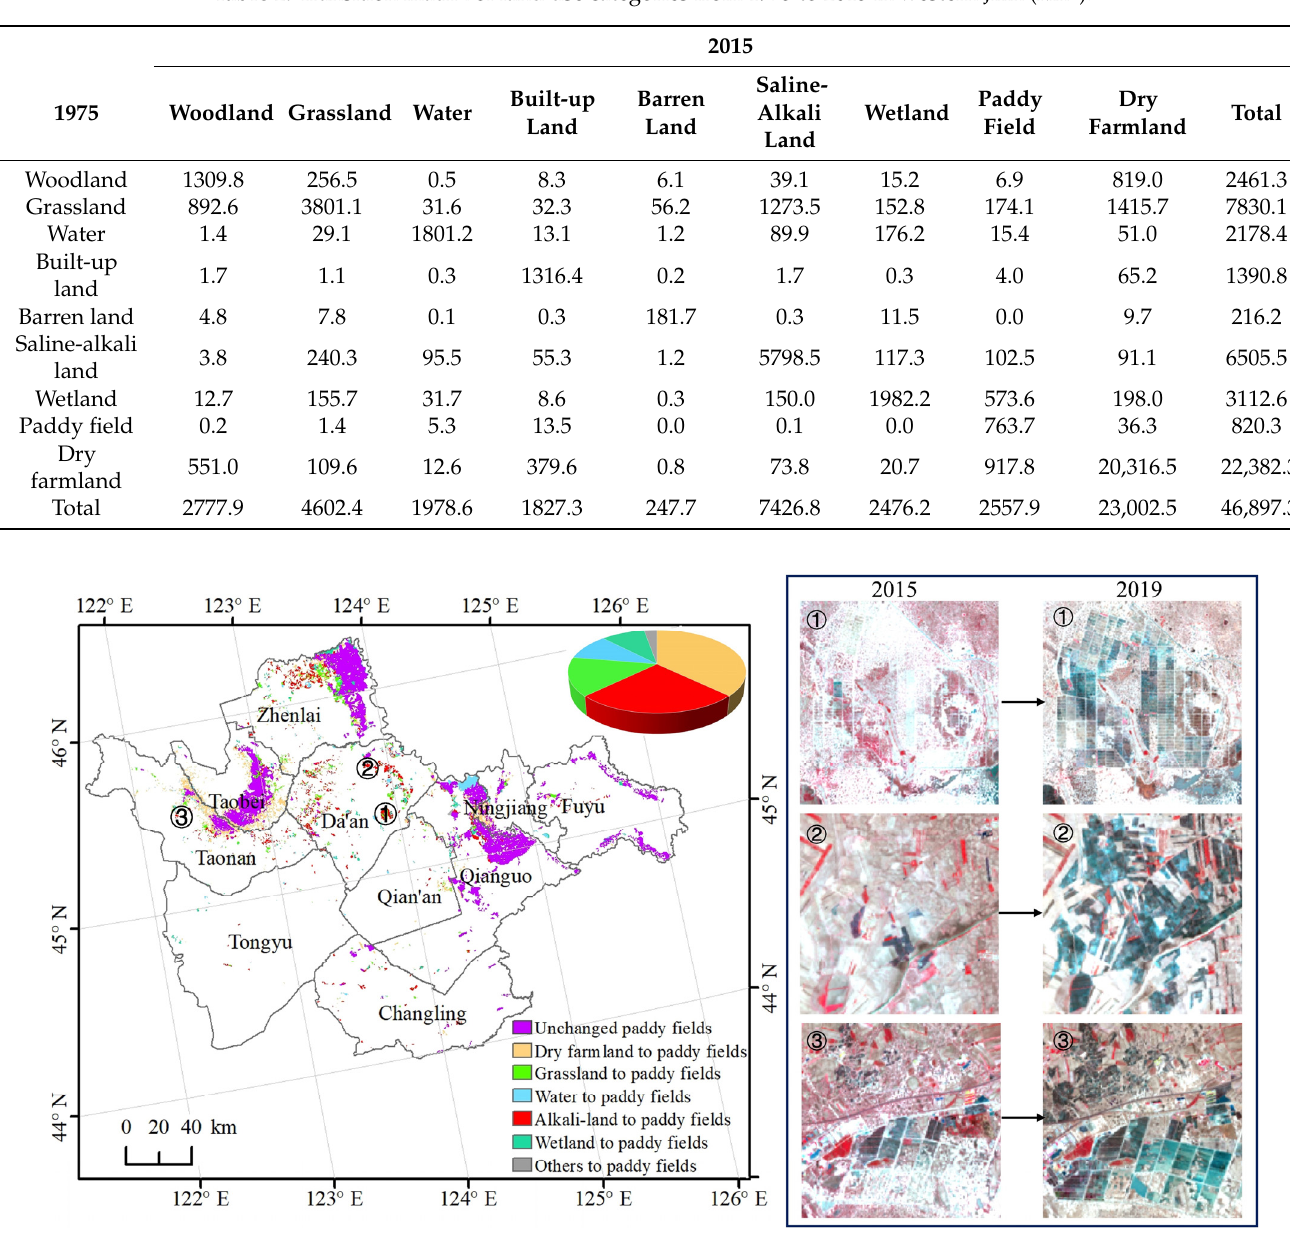
Table 2. Transition matrix of land use categories from 1975 to 2015 in western Jilin (km 2 ).